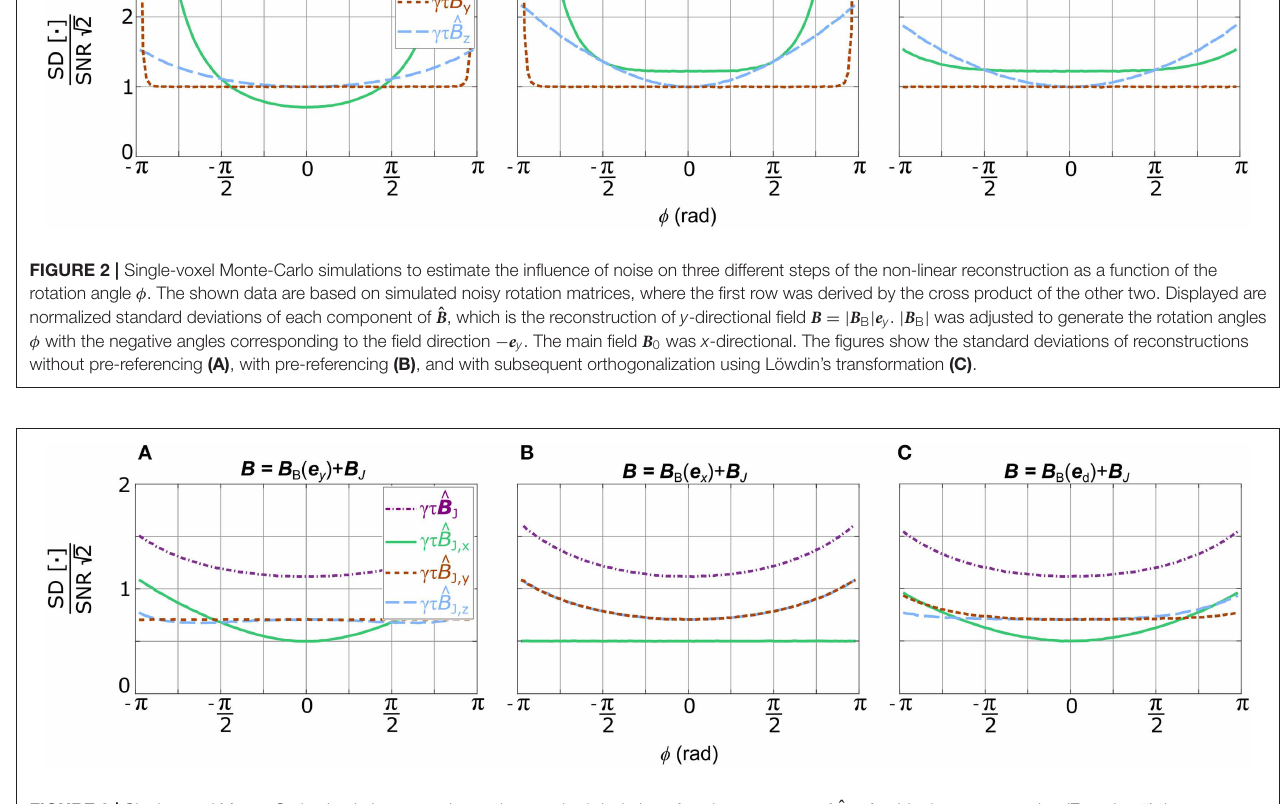
FIGURE 3 | Single-voxel Monte-Carlo simulations to estimate the standard deviation of each component of ˆ B J after bipolar reconstruction (Equation 7), in B J , where B J was set tr[cov( ˆ B J )] (Equation 16) is presented in purple, dash/dotted lines. B is the effective field B B dependence of the rotation angle φ . In addition, + q B . The figures represent reconstructions, where B B was to zero and B B was adjusted to generate defined rotation angles φ with negative angles corresponding to − y -directional (A) , x -directional (B) , and diagonally oriented in e d [1,1,1] / √ 3 (C) . The main field B 0 was x -directional in all =